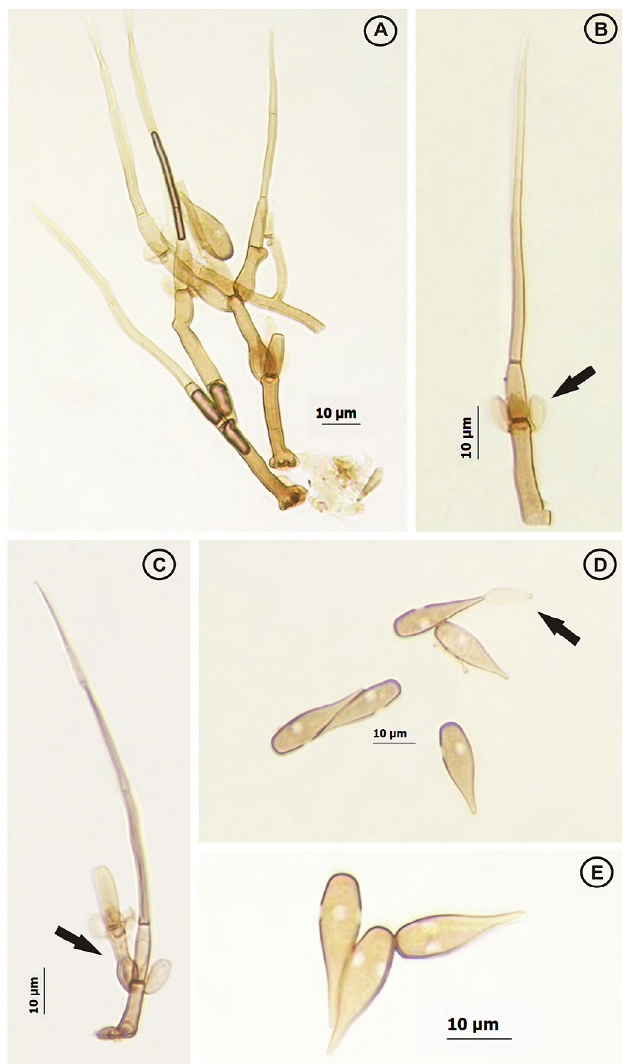
Figure 1. Porobeltraniella porosa (SP445825). A: General aspects of setiforme conidiophores. B: Conidiogenous cells (arrow) in verticil. C: Ramification of conidiophores originating from conidiogenous cell. D: Conidia and one of them with attached separating cell (arrow). E: Conidia with typical